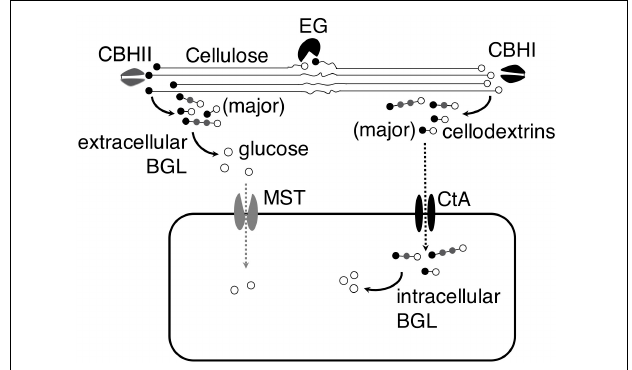
FIGURE 6 | Model of cellulose utilization in A. niger by both complete and partial hydrolysis strategies. In both strategies, cellulose is first transformed into cellobiose and cellodextrins by endoglucanase (EG) and exo-cellobiohydrolases (CBHI and CBHII). In the complete hydrolysis strategy, extracellular β -glucosidase (BGL) hydrolyzes the cellobiose and cellodextrins into glucose and then it is transferred into the cells by monosaccharide transporter (MST). However, the cellobiose and cellodextrins are transferred into the cells by cellodextrin transporter (CtA) and then they are hydrolyzed into glucose by intracellular BGL in the partial hydrolysis